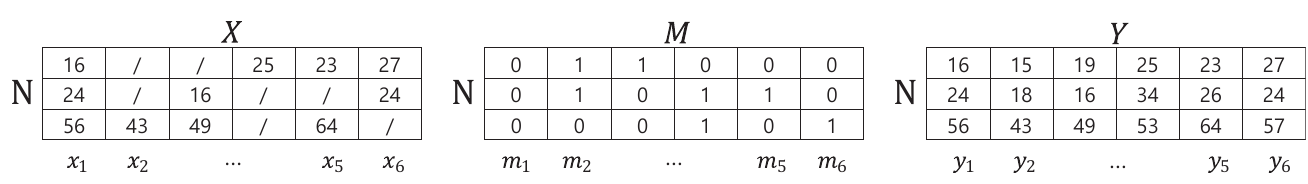
Figure 1. Example of time-series data with missing values X , its corresponding missing value mask M , and time-series data without missing values Y . The slash (/) denotes the missing values. x i ∈ R N is the i -th observation of the target variable collected from N different locations, where N = 3 for this example.